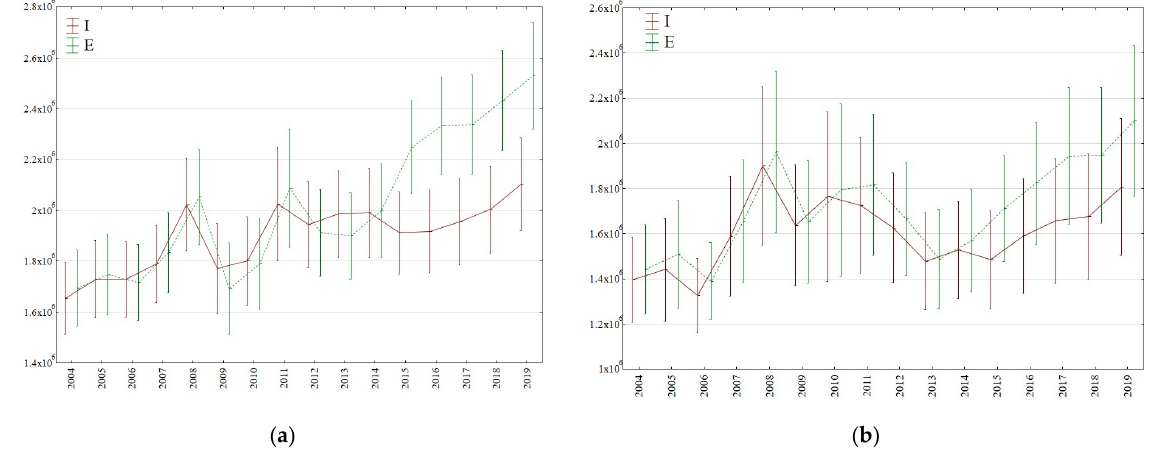
Figure 4. Development of the position and variability of the RCR index depending on the legal form in the period 2004–2019: ( a ) cooperatives; ( b ) non-cooperatives.